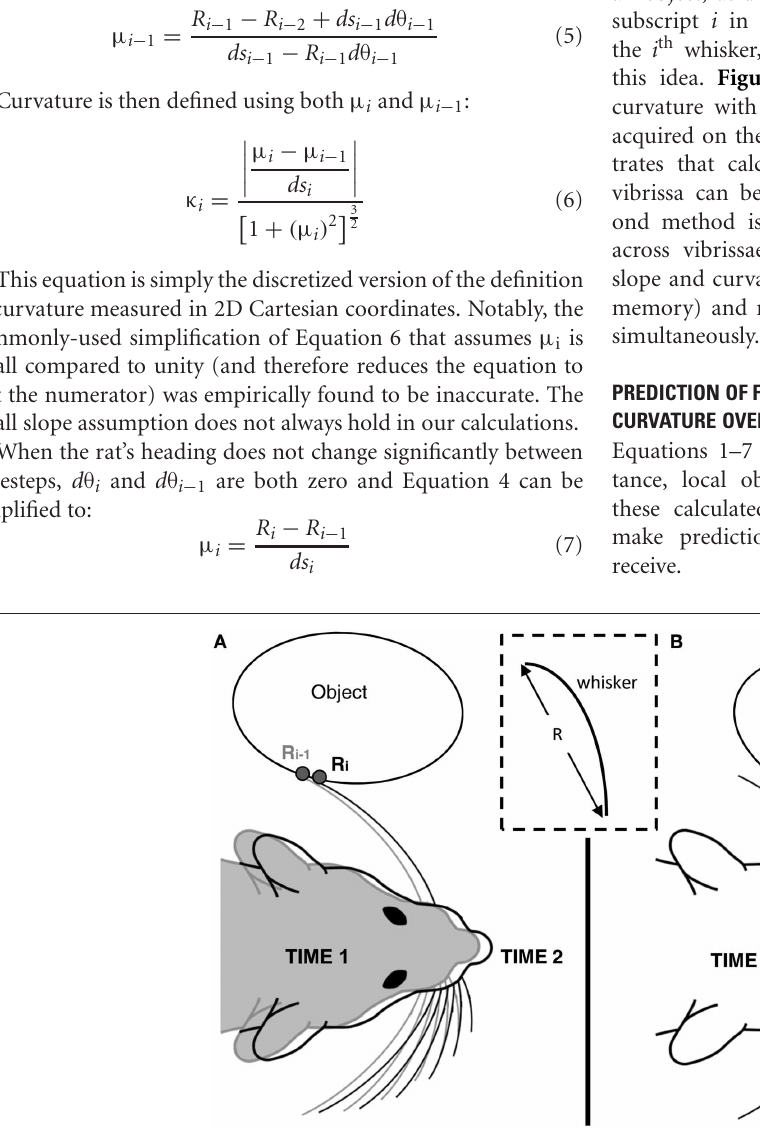
gray indicates the location of the rat at time 1, and the rat in black outline indicates the location of the rat at time 2, having translated slightly forward. (B) In the multiple whisker method, we imagine that the rat compares data across whiskers in the array at a single point in time. Both methods (A) and (B) can be used simultaneously to explore these different spatial scales in